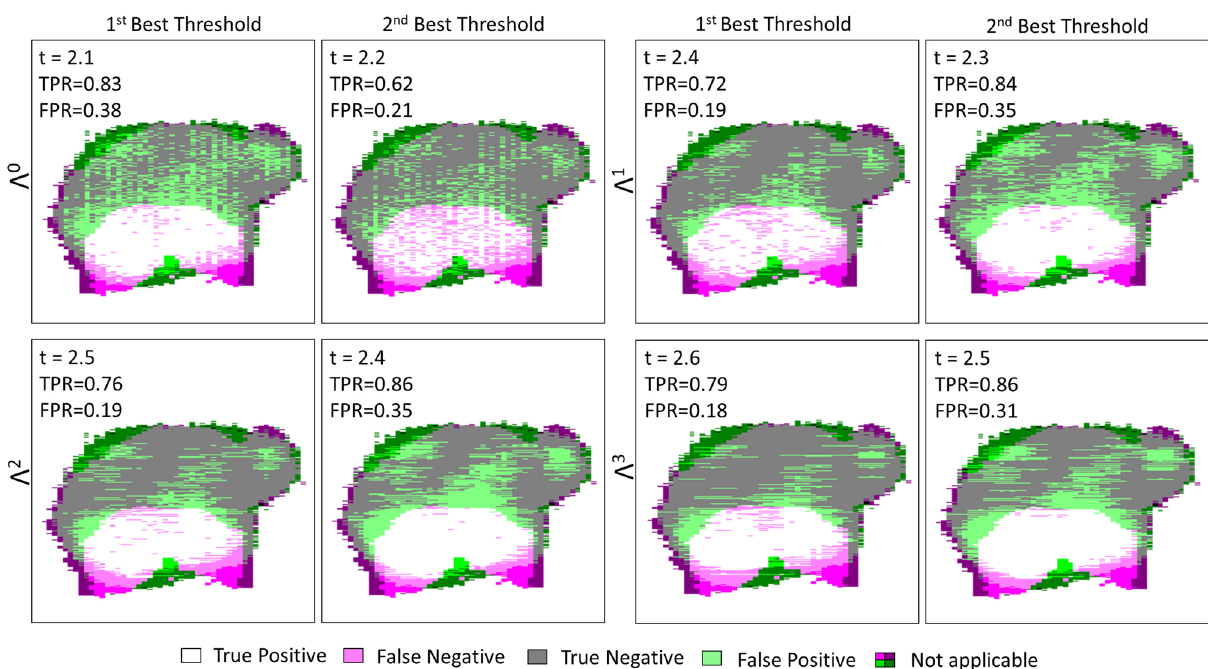
0 1 2 3 , (cid:31) , (cid:31) , (cid:31) and their respective first two